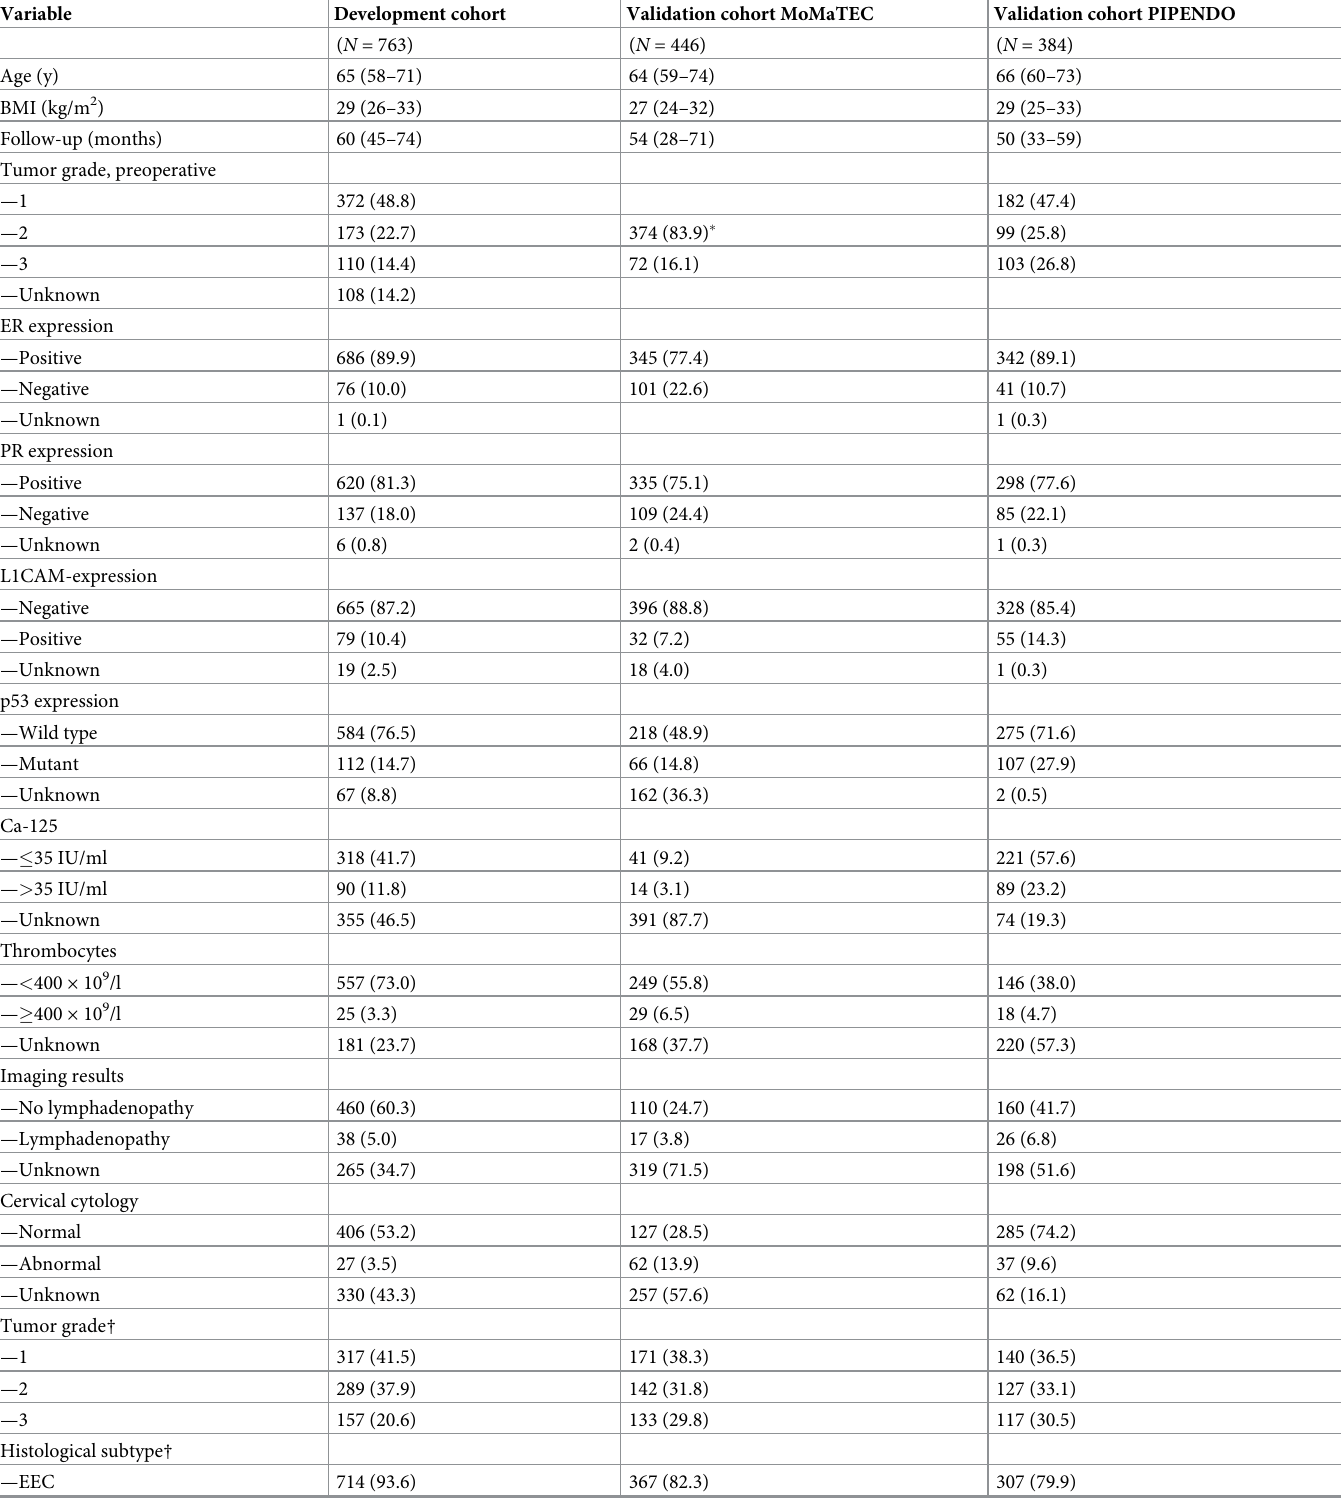
Table 2. Baseline characteristics of development cohort and 2 validation